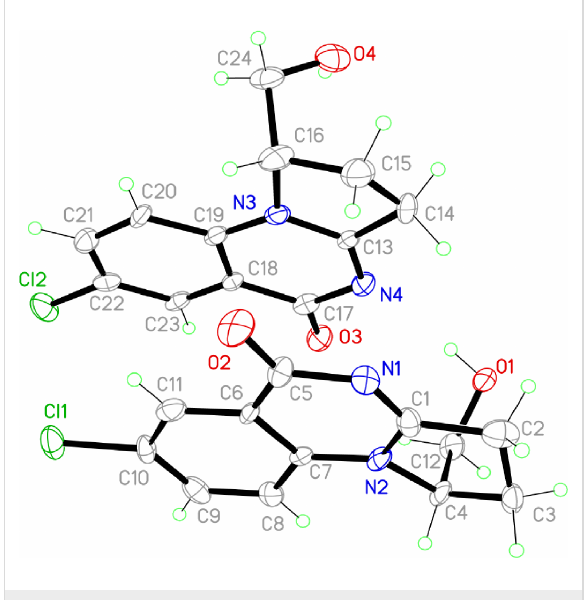
Figure 2: X-ray crystal structure of compound 6f .